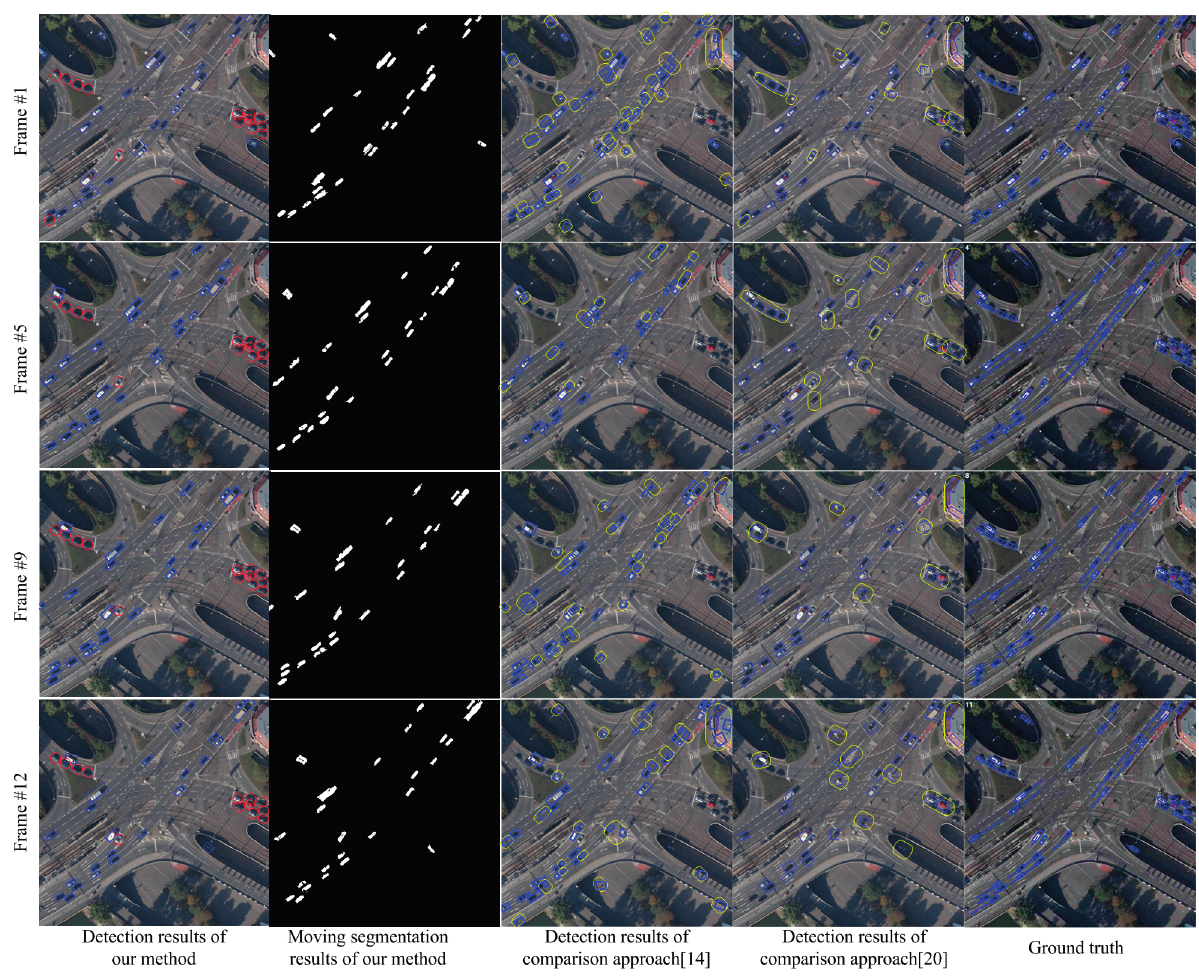
Figure 4. Detection comparisons in complex overpass